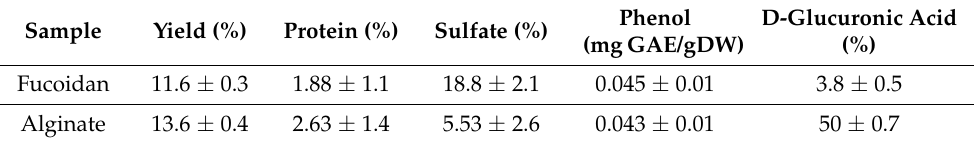
Phenol D-Glucuronic Acid (mg GAE/gDW) (%)